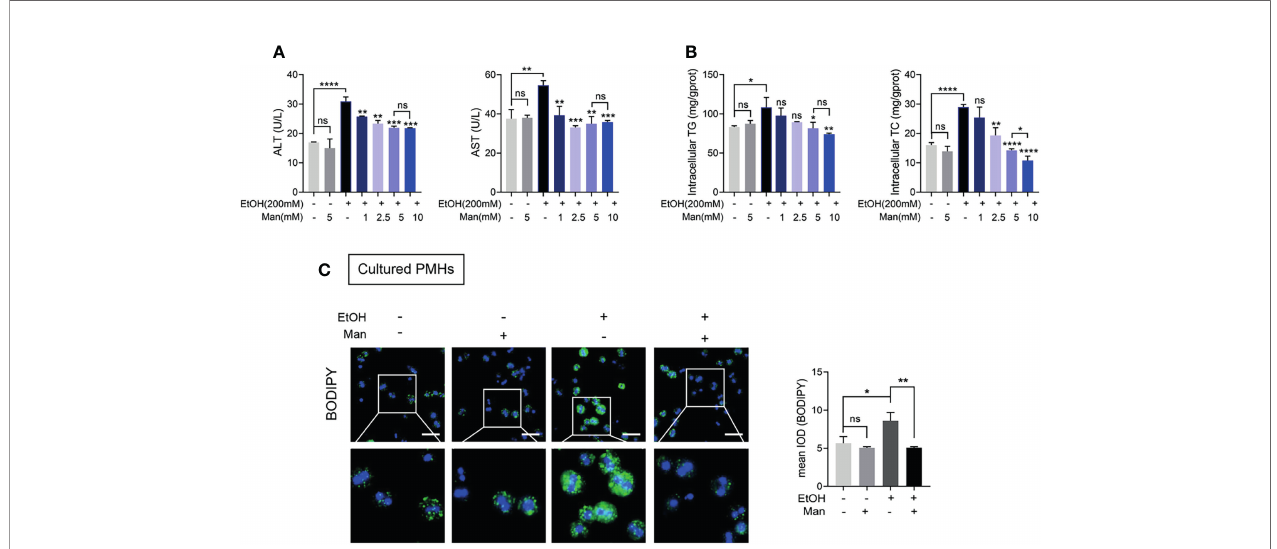
FIGURE 2 | Mannose treatment attenuates ethanol-induced lipid accumulation in PMHs. PMHs isolated from WT mice were stimulated by 200 mM ethanol (EtOH) with different concentrations of mannose (Man) for 24 h (n = 3). (A) The ALT and AST activities in the culture supernatant were measured. (B) The intracellular TG and TC contents were determined. (C) The content of neutral lipids was detected by double staining with BODIPY 493/503 dye and Hoechst in PMHs (cultured with 5 mM mannose). Scale bars = 50 m m. Data are presented as the mean ± SEM of three independent experiments and analyzed with the unpaired two-tailed t-test. * p < 0.05, ** p < 0.01, *** p < 0.001, **** p < 0.0001, ns, not signi fi cant, compared with the EtOH